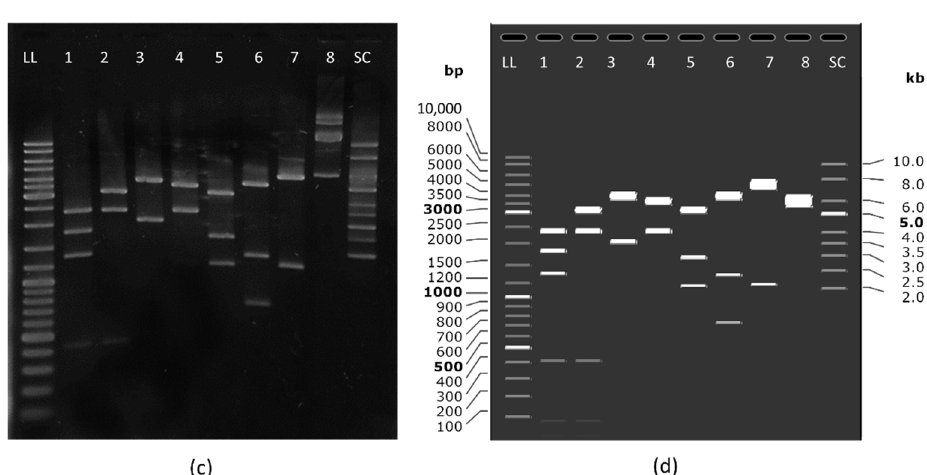
Figure 2. Construction and confirmation of the p21-mIL-12-ORT plasmid. ( a ) Cloning plan created using the SnapGene software: the expression cassette carrying the murine IL-12 sequence under the EF1/HTLV promoter was cut out of the pORF-mIL-12 (p40:p35) plasmid with the Not I and Swa I (blunt end) restriction enzymes and ligated to the pCR-blunt psiCAT plasmid cut with Not I and Pml I (blunt end). In the resulting plasmid, the promoter region was replaced with the p21 promoter from the p21-hIL-12-ORT plasmid using the Not I and Sal I restriction enzymes. The chloramphenicol antibiotic resistance gene (CmR) was then removed from the p21-mIL-12-Xmark plasmid using the ORT technology, resulting in the p21-mIL-12-ORT plasmid. ( b ) Annotated plasmid map: p21 promoter–promoter region from the native human p21 (CDKN1A) gene, mIL-12 (p40:p35) murine IL-12 intronless open reading frame consisting of the IL-12b (p40, beta subunit) and IL-12a (p35, alpha subunit) genes, SV40 polyA-simian virus 40 late polyadenylation signal, ORI- E. coli origin of replication, LacP lactose operon promoter with the lacO operator. ( c , d ) Restriction analysis: ( c ) the plasmid was cut with different combinations of restriction enzymes and its identity was confirmed by positive matching of the pattern of bands on the electrophoresis gel to the expected ( d ) pattern obtained by means of a simulation experiment using the SnapGene software. For the uncut plasmid, the simulated band pattern differs from the actual pattern because simulation can only be done for a supercoiled monomer, while other forms (supercoiled dimer, open circular, linear, nicked) can also be seen on the electrophoretic gel. Electrophoresis details: 1% agarose (Sigma-Aldrich), run for 45 min at 100 V/cm, stained in 1 × Sybr Gold (Thermo Fisher Scientific). LL (linear DNA ladder): GeneRuler™ 1 kb Plus DNA Ladder (Thermo